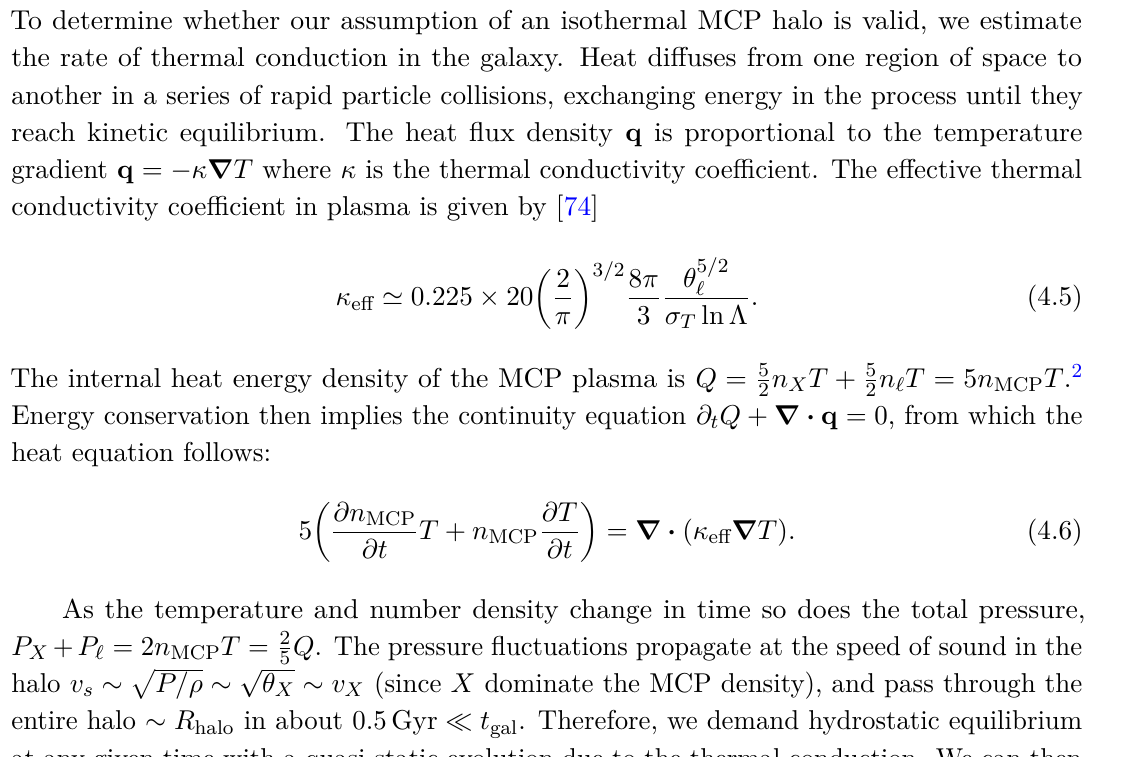
(right) as a function of the mfp is compared to the halo length R halo mfp